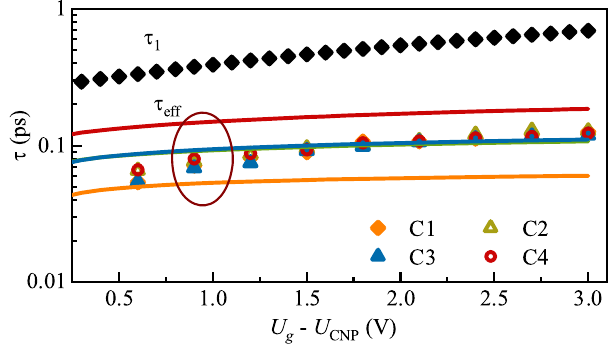
FIG. 13. Relaxation time as a function of the gate bias. τ 1 is the momentum relaxation time in the active region shown as the black diamonds, τ is the plasmon relaxation rate calculated eff using Eq. (15) (solid lines), and color dots are experimental τ